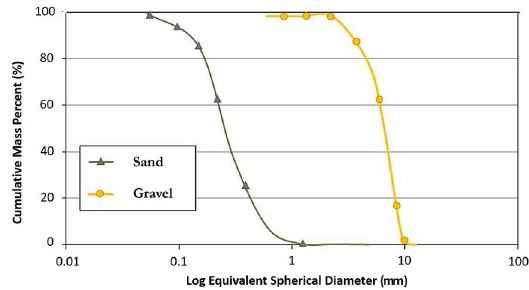
Figure 5. Particle size distribution of the sand and the coarse aggregate